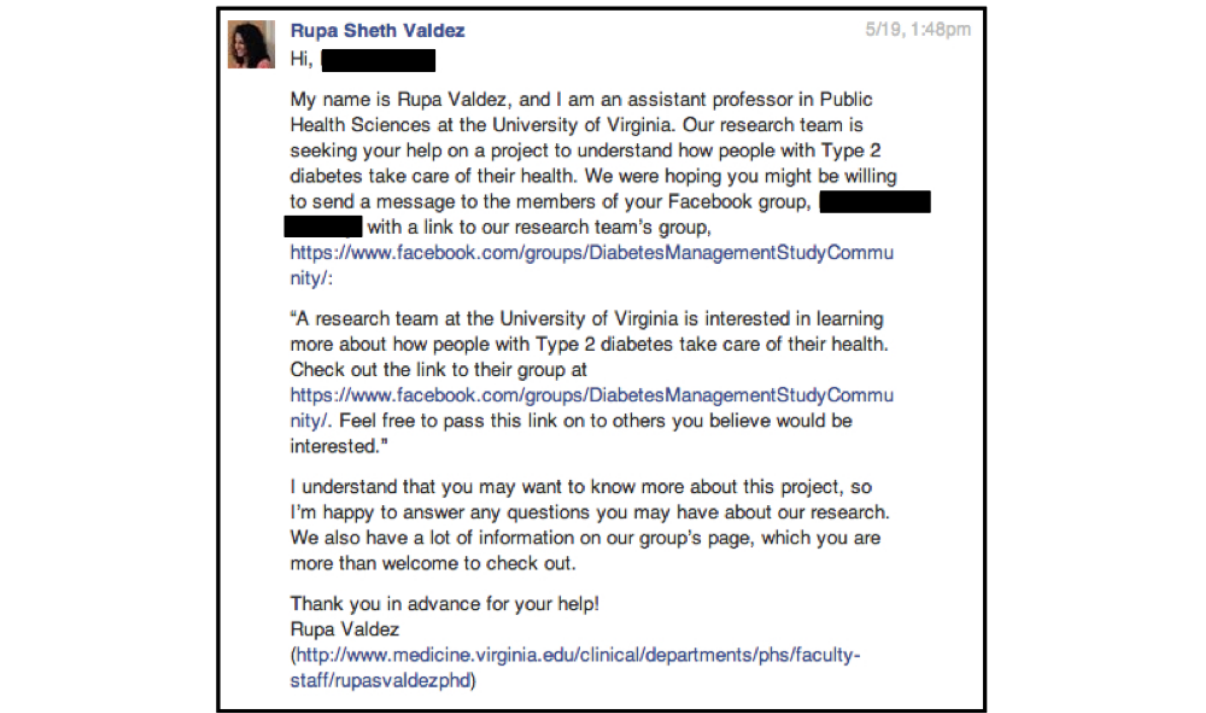
Figure 3. Message to groups and pages for Study